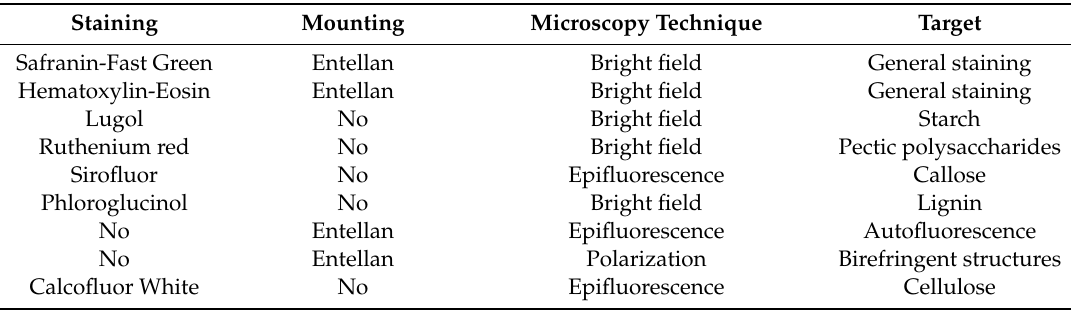
Figure S1: Graft junctions at (a–d) 10 and (e–k) 20 DAG. a, b, e, f, i, k Homograft; c, g, j Minibel (scion)–Marmande VR (rootstock) heterograft; d, h Marmande VR (scion)–Minibel (rootstock) heterograft. Scale bars: a–h, k = 1 mm; i, j = 0,5 mm. ar adventitious roots, c callus, RS rootstock, SC scion. In a–h the scion is the top part and rootstock the bottom part. Note the adventitious roots arising on the scion and the changes in the callus development. i, j Callus detail. k Unsuccessfully grafted plant, note the absence of scion–rootstock adhesion; Figure S2: Details of graft histological development. a Pre-existing vascular tissue (PV) at 10 DAG; note how the most distal end is composed of dead cells only. b Longitudinal section of the expansion of the callus (CE) at 20 DAG; note the xylem (x) and the parenchyma (pa) towards the exterior. c and d Vestiges of the graft process at 210 DAG: c Transverse section of the graft junction area, showing the discontinuity of the vascular ring. d Transverse section of the graft junction area; note the anomalies of the vascular ring. a Hematoxylin-Eosin; b–d Safranin-fast green. a–d Bright field view. CE, callus expansion, na non-adhesion, pa parenchyma, ph phloem, PV pre-existing vascular tissue, RS rootstock, SC scion, x xylem. Scale bars: a, d = 100 µ m; b, c = 200 µ m; Figure S3: Longitudinal sections staining for polysaccharides (calcofluor White -cellulose- and ruthenium red -pectins-) from homografts. a Rootstock section at 2 DAG; note the cut edge, especially the crushed cells and remnants (ccr), as well as the intense fluorescence from cellulose of these cell walls. b Rootstock section at 4 DAG; note the deposition of high amount of pectins at the cut edge. c Early graft union section at 8 DAG; note the line of adhesion with cellulosic cell wall thickenings. d Graft union section at 20 DAG; note the permanence of the pectin depositions at the adhesion line as well as vascular (re)connections (vc). e Graft union section at 20 DAG; note the cellulosic cell walls at line of adhesion and transversal section of vasculature (xylem and phloem). a, c, d Calcofluor White; b, e Ruthenium red. a, c, d Epifluorescence microscopy. b, e Bright field view. ccr crushed cells and remains, pd pectin deposition, ph phloem, RS rootstock, SC scion, VC vascular connections, x xylem. Green asterisk indicates cut edges. Triangle arrows indicate adhesion line. Scale bars: a, c = 50 µ m; b, d, e = 100 µ